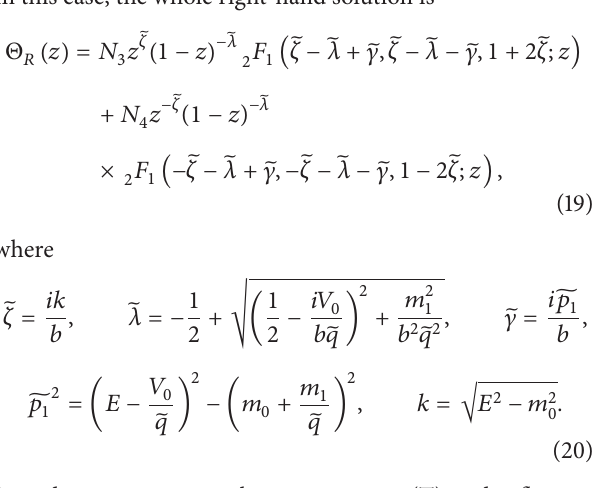
Table 2: The abbreviations taking part in (26), (34), and